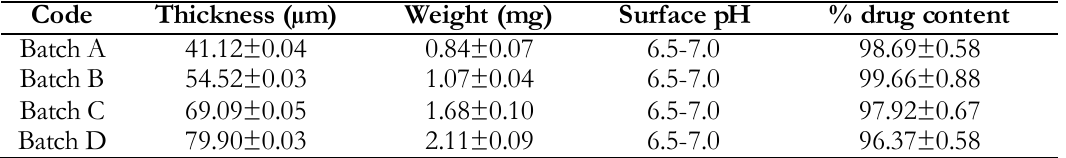
Table II. Evaluation of ocular inserts